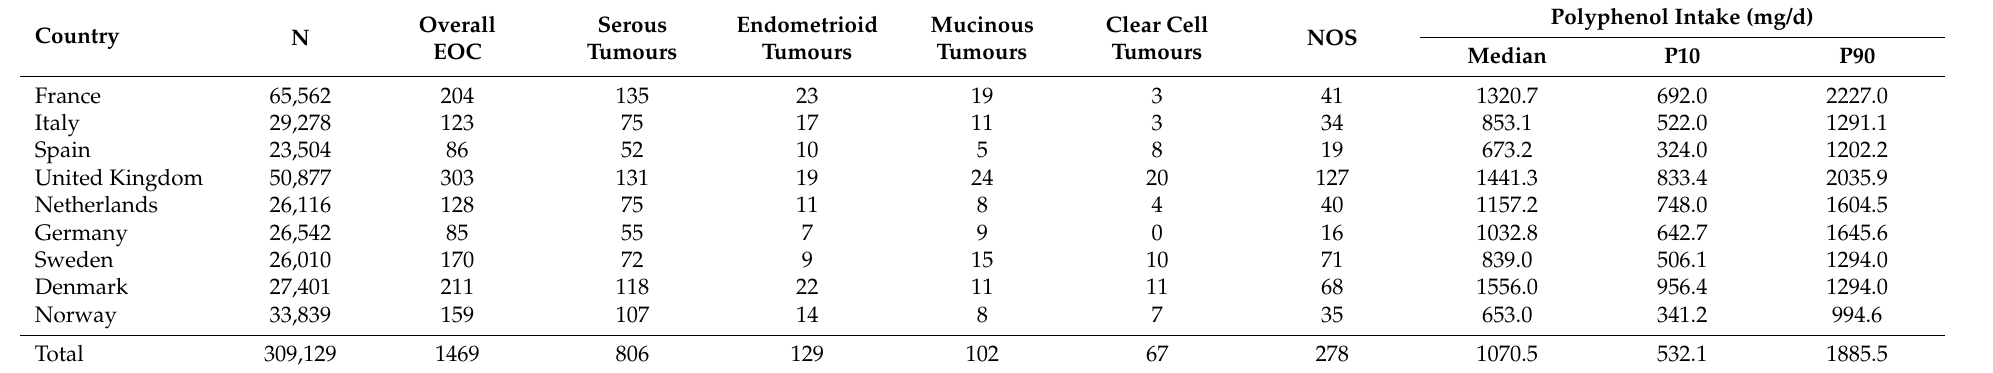
Table 1. Number of total and histological subtypes of EOC cases and median (10th–90th percentile) of total polyphenol intake by country in the EPIC study.